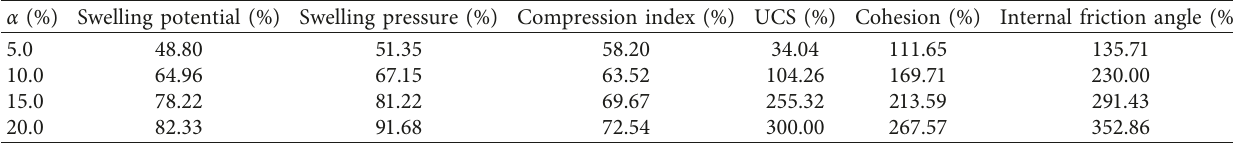
Table 6: The improvement rate of stabilized expansive soil.